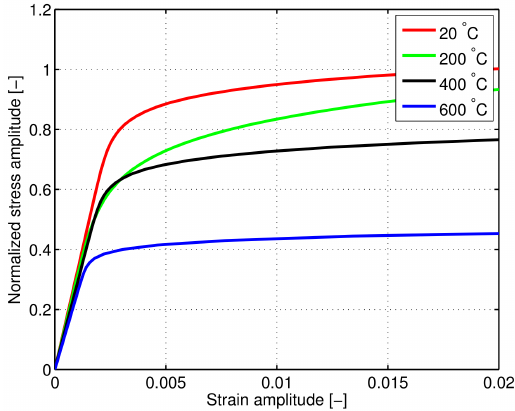
Figure 2. The temperature dependent cyclically stable cyclic stress-strain curves.